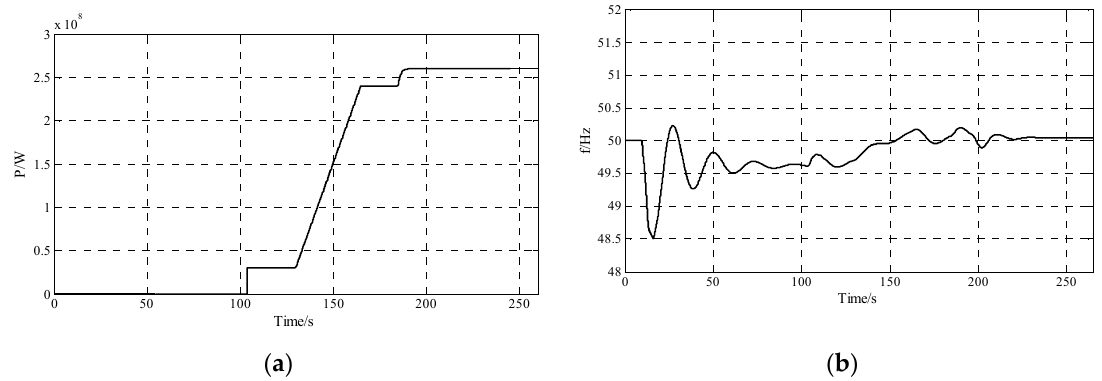
Figure 29. Simulation waveform in generating mode. ( a ) power flow on 18-kV bus; ( b ) the frequency of the system.